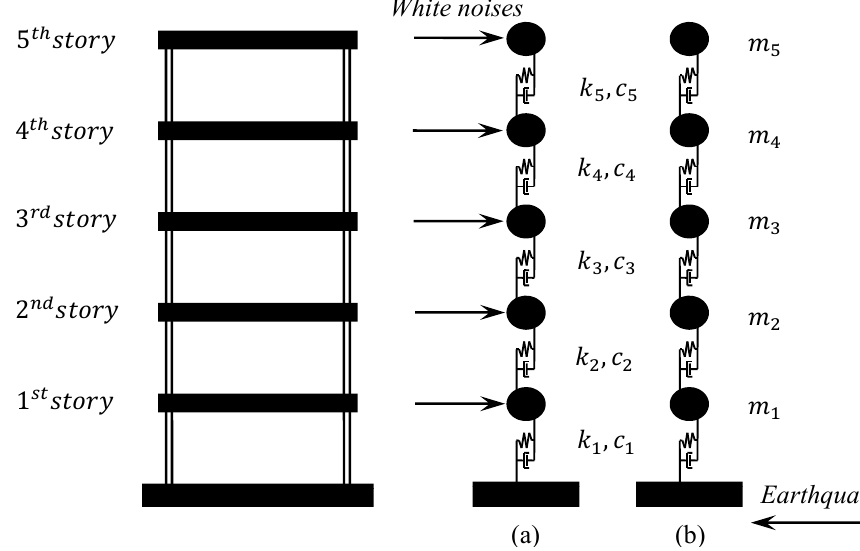
Figure 3. Five-story shear building model subjected to: ( a ) mutually correlated inputs of white noises; Figure 3. Five ‐ story shear building model subjected to: (a) mutually correlated inputs of white ( b ) earthquake noises; (b) earthquake excitation.